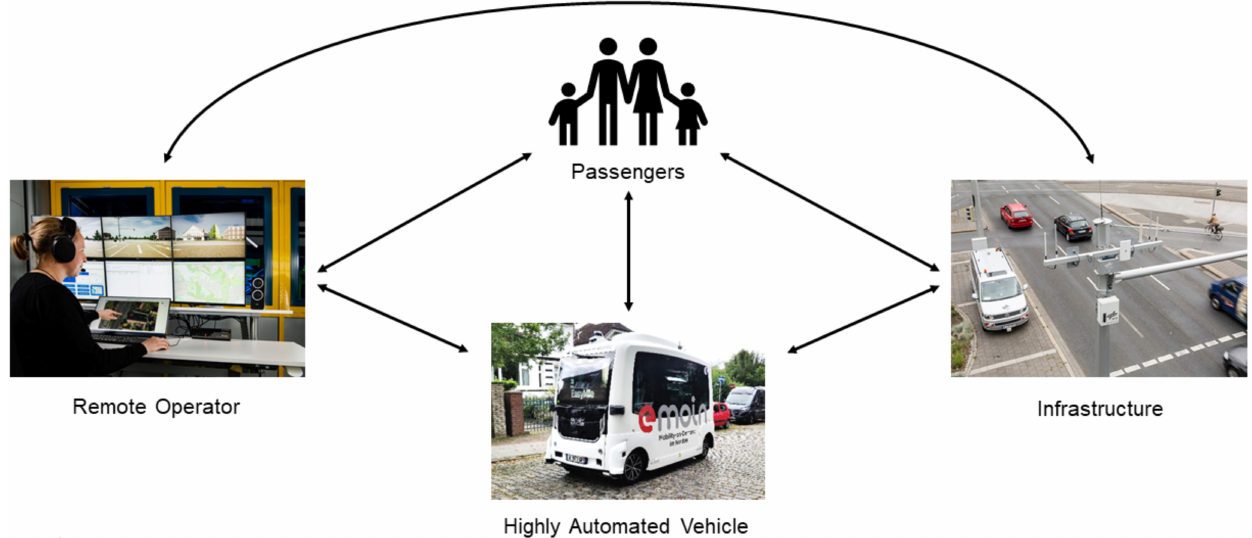
Figure 7. Most relevant actors interacting in the compiled scenarios on remote operation of highly automated vehicles. The remote operator, the highly automated vehicle, the passengers, and the infrastructure collaborate with each other to complete the driving task at SAE Level 4. Adapted with permission from Ref. [30]. 2022, DLR (CC BY-NC-ND